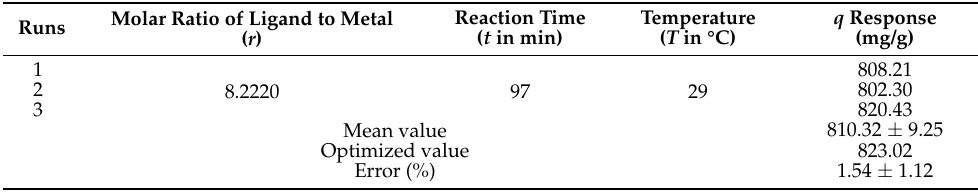
Table 3. Validation results of the optimization study on the synthesis of ZIF-L.